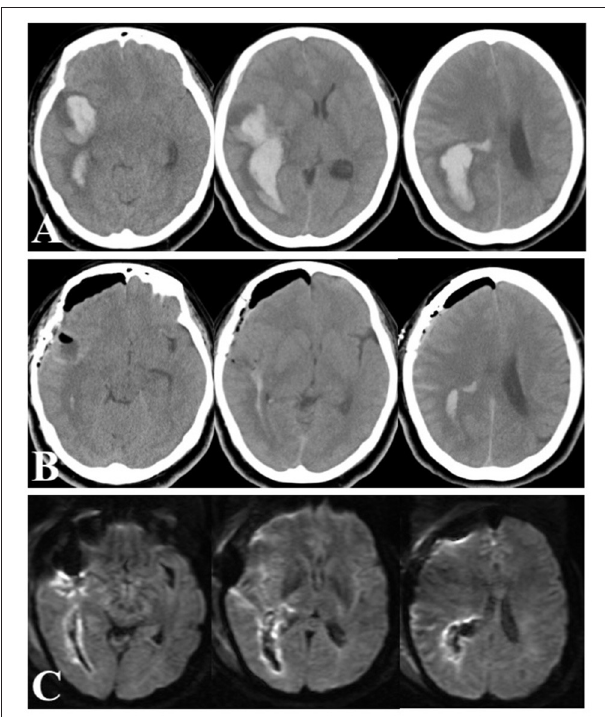
FIGURE 4 | Head CT scans on arrival (A) , immediately after ICH removal (B) , and diffusion-weighted MRI images next day (C) .